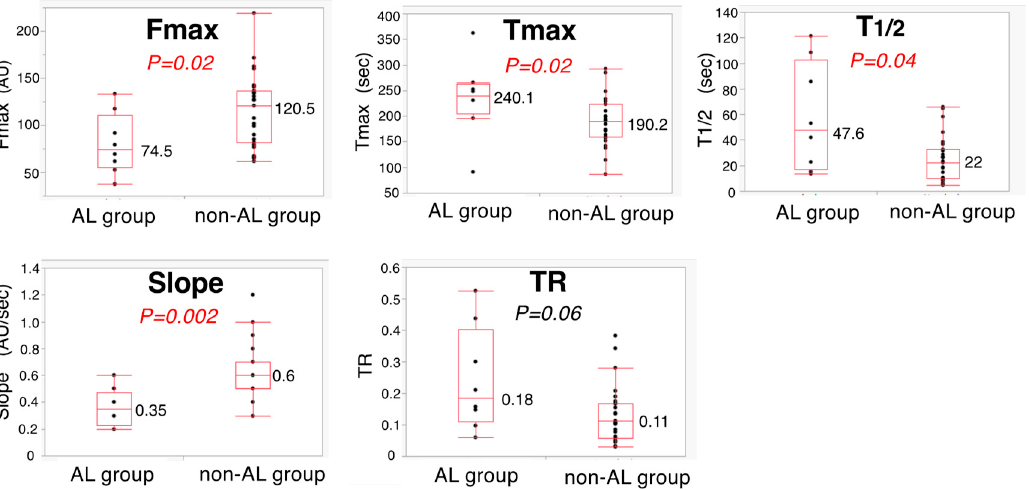
Figure 6. Comparison of five ICG fluorescence-related parameters between AL group and non-AL group.